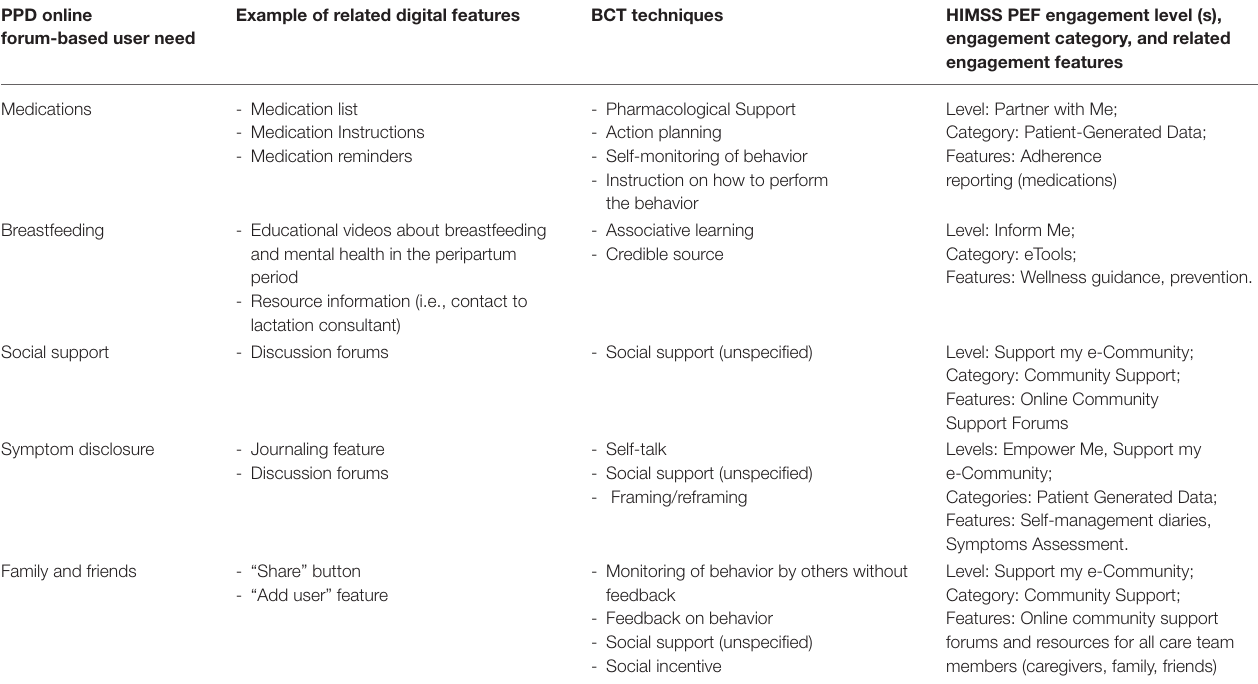
TABLE 7 | Mapping of PPD digital features to behavior change techniques and engagement